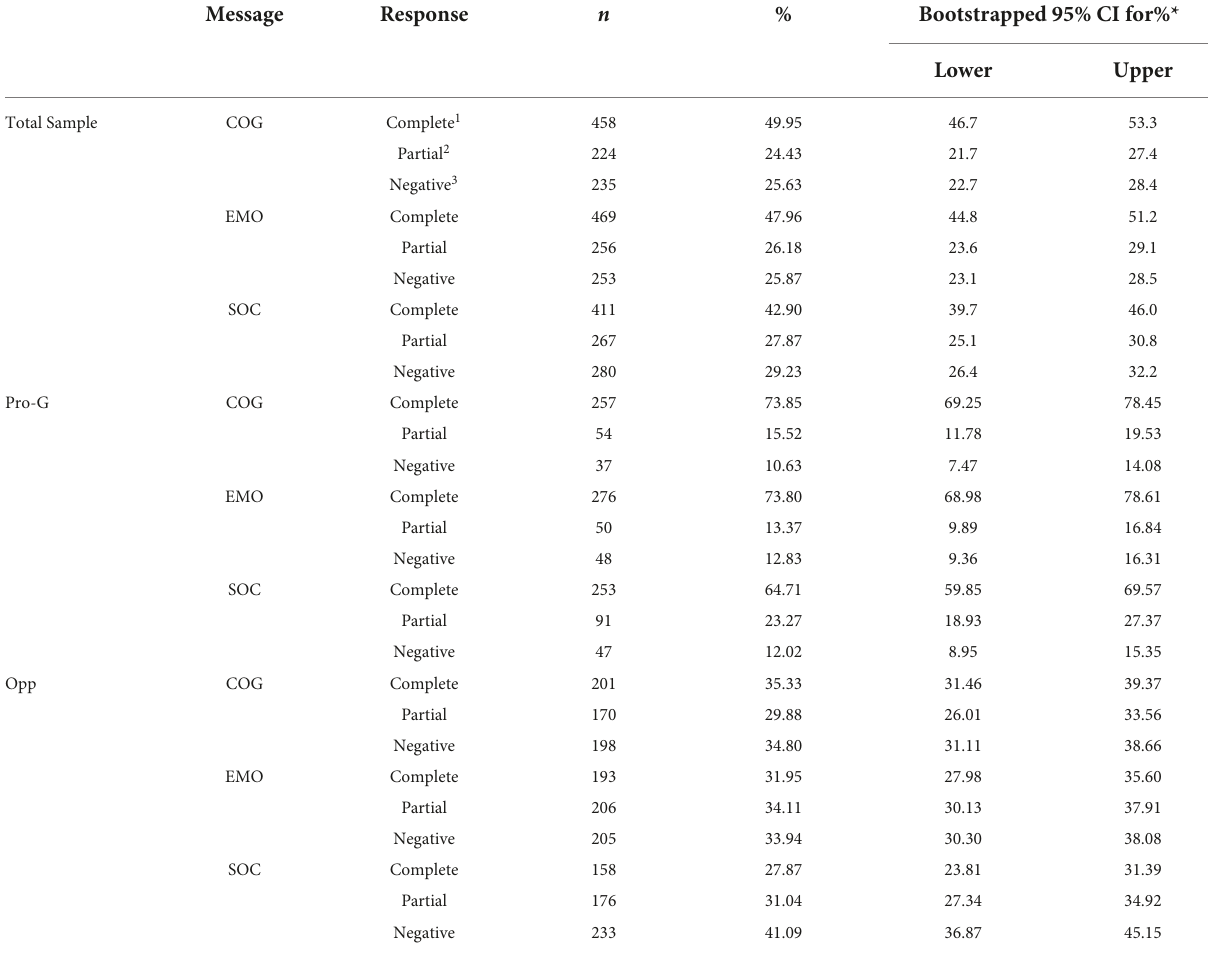
TABLE 6 Outcome of messages by category of